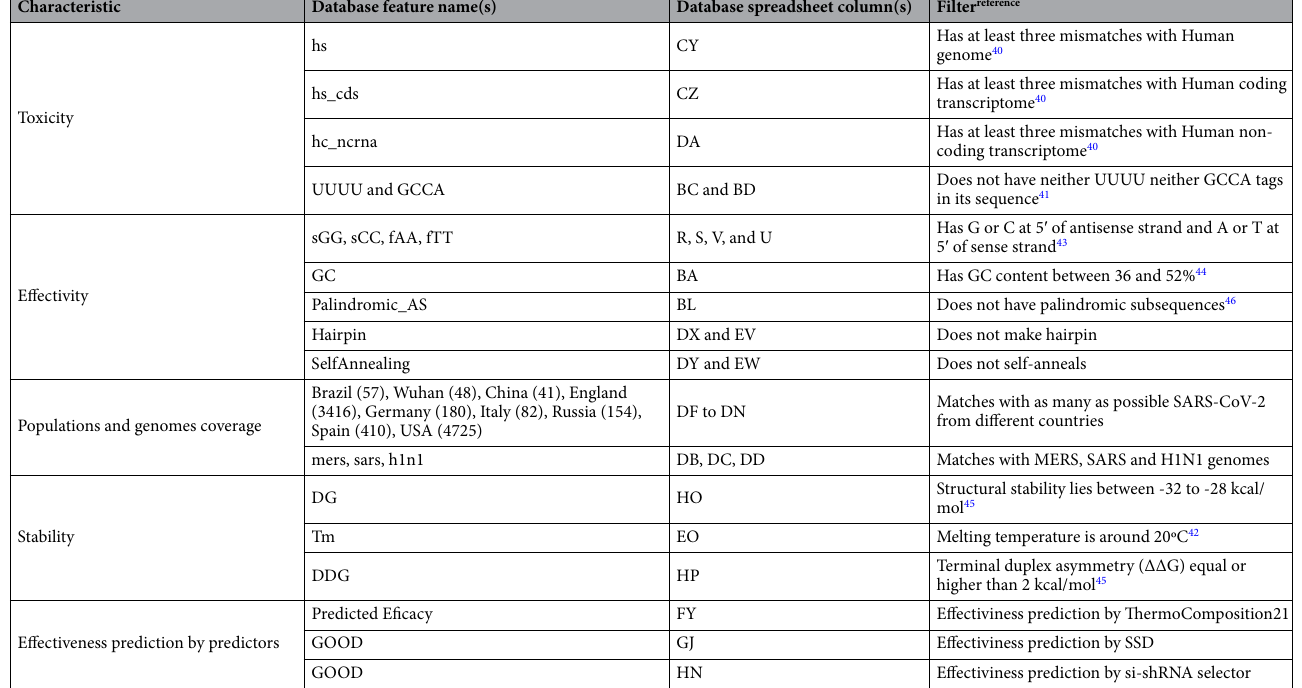
Table 2. Example of siRNAs filtering criteria according to diverse characteristics. Criteria filtering sets from literature regarding (a) Toxicity, (b) Efficiency, (c) Populations and genomes coverages, (d) Stability, and (e) Effectiveness prediction. First column indicates each such group of characteristics; second column, the name of database feature whose filtering criteria (last column) is related; third column, the spreadsheet database column related to database feature name; and last column, the filtering criteria.